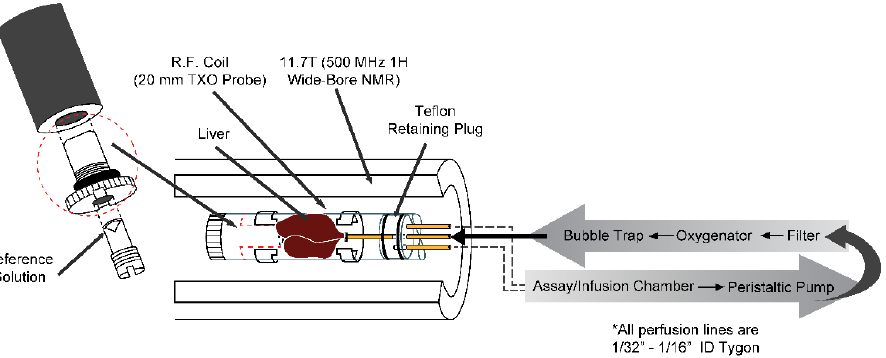
Figure 1. Schematic of the perfused liver apparatus. The liver sits inside a custom-made 20-mm NMR tube which is inserted into a 20-mm 13 C/ 31 P/ 1 H TXO probe. The observed 13 C NMR signals arise from the liver and approximately 10 mL of the surrounding perfusate. The assay/infusion chamber allows for periodic sampling of the perfusate and administration of exogenous compounds. The oxygenator consists of Silastic tubing continually bathed in 95% O 2 /5% CO 2 gas and wound around a hollow cylinder filled with water, the temperature of which is controlled via external water bath. *All other perfusion lines are Tygon tubing of inner diameter 1/32” to 1/16”. Reprinted from reference